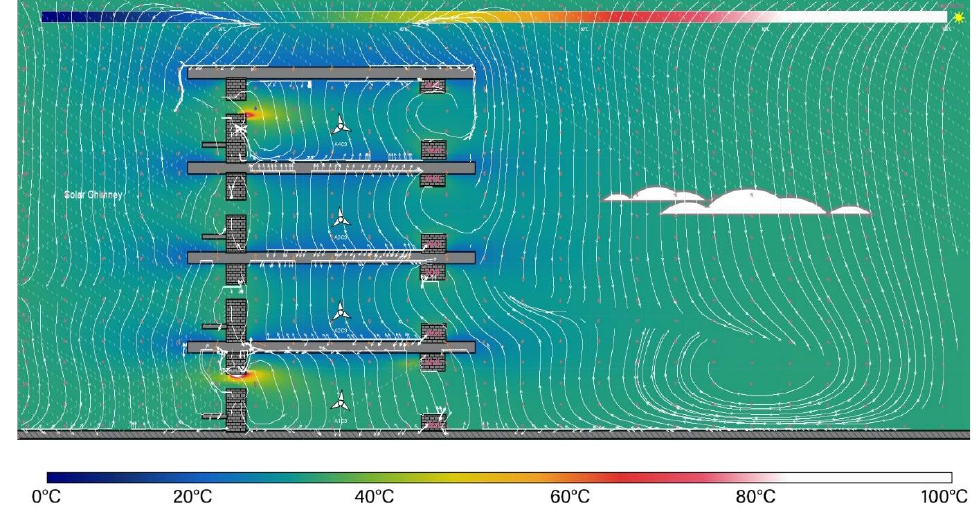
Figure 8. A sectional view of the simulation setup in Energy2D. The results of Sensor A3C3 (Level 3 simulation) were compared against the field measurements shown in Section 2.2.1.